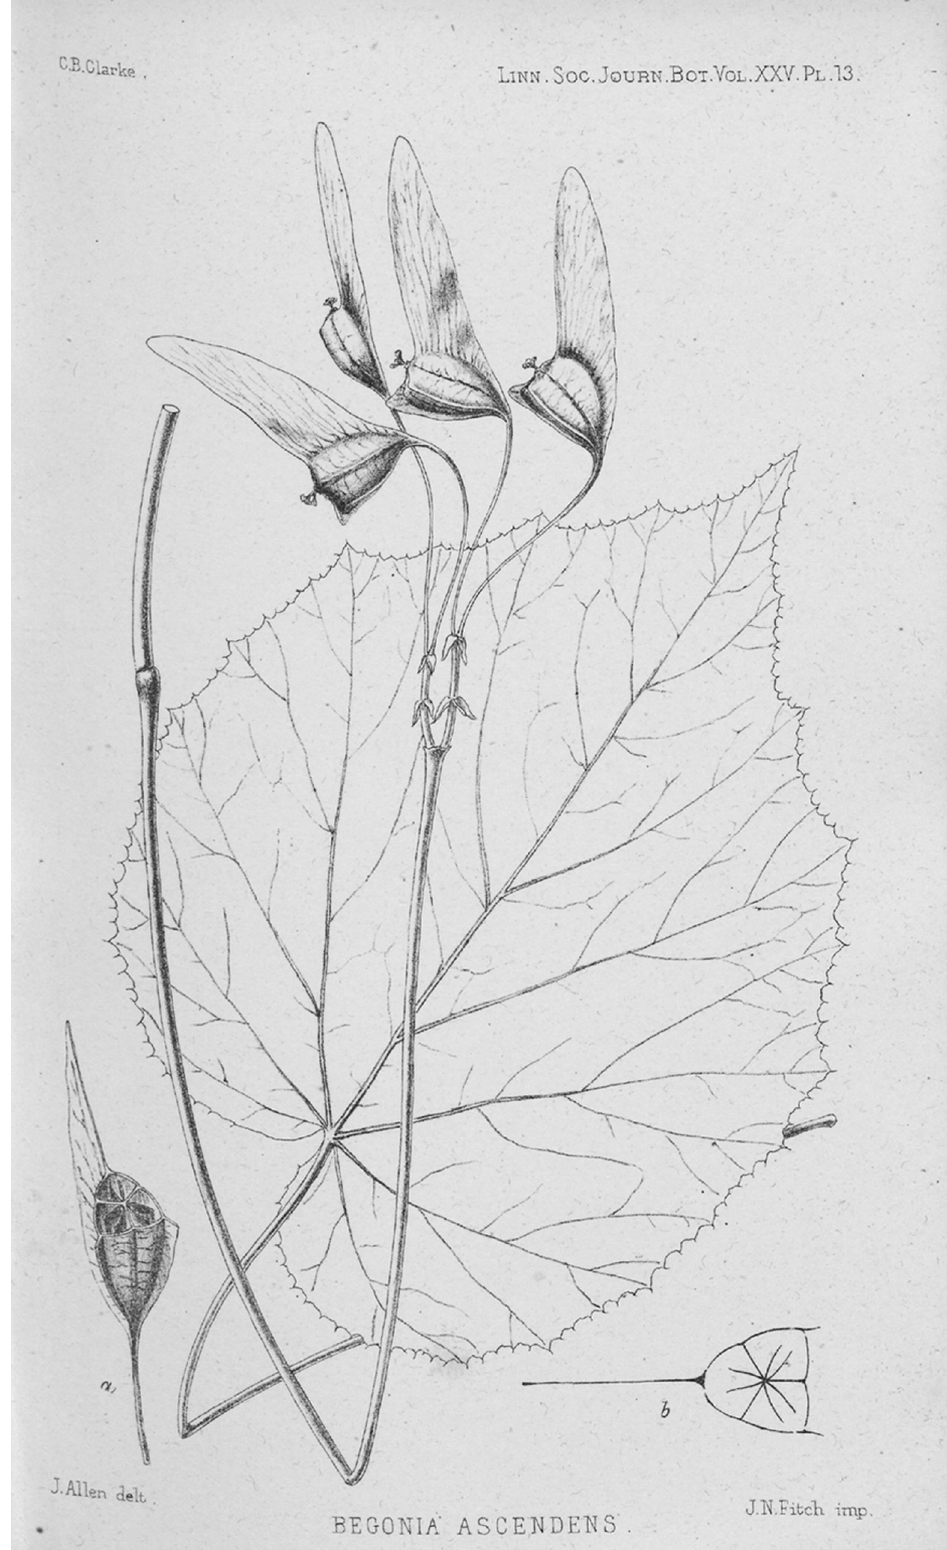
Fig. 9. Illustration of B. adscendens C.B.Clarke by J. Allen (Clarke 1890). a. Dissected fruit capsule. b. Fruit cross-section diagram. Image courtesy of RBGE library and Lynsey